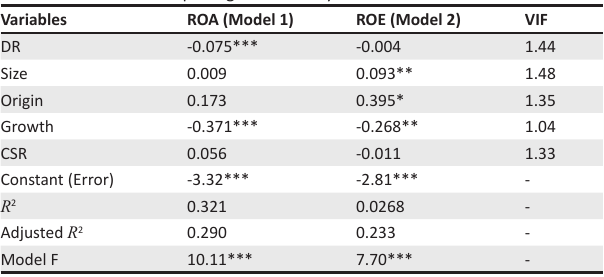
TABLE 4: Standard multiple regression